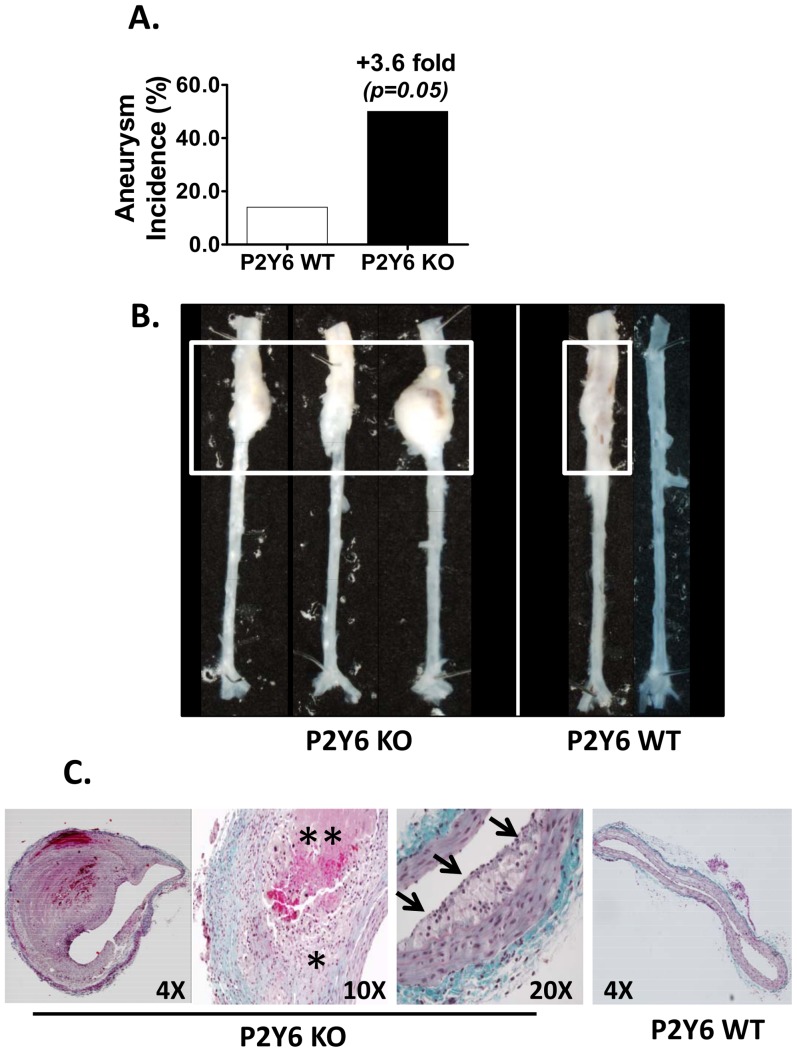
Abdominal Aortic Aneurysms.
A) Incidence of aneurysm development in the abdominal aorta. B) Representative images of abdominal aortic aneurysms for P2Y6 KO mice and P2Y6 wild-type mice. Aneurysm-positive and -negative aortas are given for P2Y6 KO wild type mice. Aneurysms are demarcated by the white boxes. C) Trichrome-stained histological sections of aneurysms taken from the supra-renal section of the abdominal aorta. Sections were cut from the center of the aneurysm mass. The single asterisk denotes the highly inflamed and remodeled adventitial mass. The double asterisk denotes a region of apparent hemorrhage. Neo-intimal plaque is shown by the arrows. The image at the far right shows an abdominal aorta cross-section taken from P2Y6 wild type mice. The magnification scale for each image is shown.